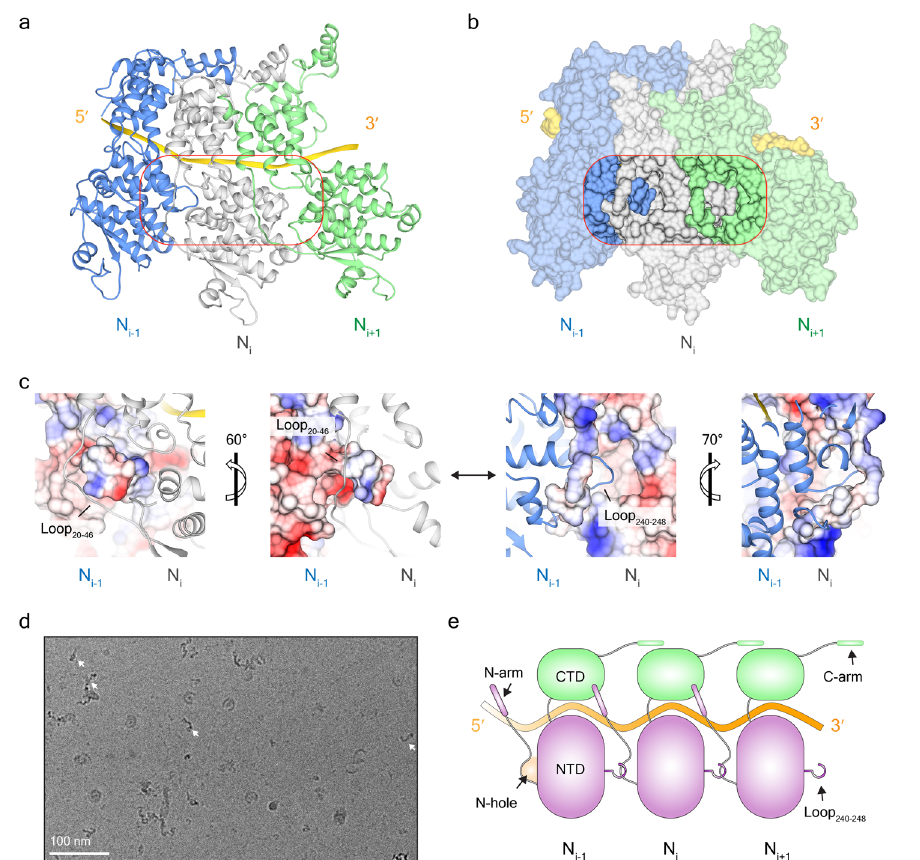
Fig. 2 The assembly mechanism of the helical stem of double-headed SeV nucleocapsids. a The atomic model of three neighboring protomers in the helical stem. Protomers are colored in blue, gray, and green, respectively, and RNA is colored in gold. An unnoticed swapped interface between neighboring protomers is boxed in red. b Molecular surfaces of three neighboring protomers with the same view as in a . The same box is applied for the new interface. The transparency values of the boxed area and the other part are set to 0% and 40%, respectively. c Electrostatic interaction between N-hole from N i – 1 and Loop 240 – 248 from N i . On the left two images, N i – 1 is represented in the contour surfaces of electrostatic potential, and N i is displayed in the ribbon. On the right two images, N i – 1 is displayed in the ribbon, and N i is represented in the contour surfaces of electrostatic potential. d Threading thin fi laments formed by Loop 240 – 248 replacement mutant. Typical threading fi laments were marked with arrows. e A model illustrates domain swapping mechanism in neighboring